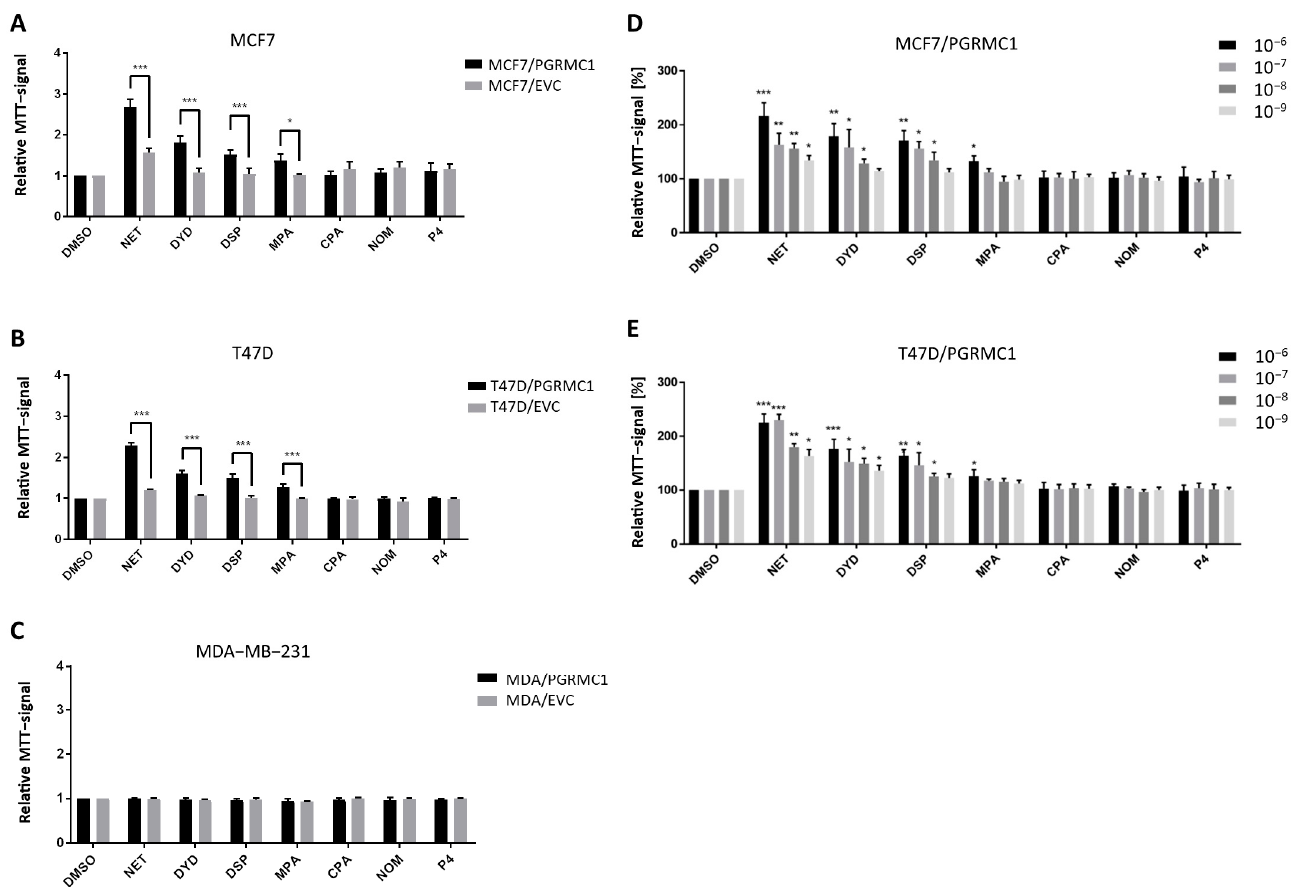
Figure 1. PGRMC1 promotes proliferation of breast cancer cells upon progestin treatment. Relative MTT-signal as surrogate for cell number of ( A ) MCF7/PGRMC1 and MCF7/EVC cells, ( B ) T47D/PGRMC1 and T47D/EVC cells, ( C ) MDA-MB- 231/PGRMC1 and MDA-MB-231/EVC cells. Cells were treated with different progestins in the concentration of 10 − 6 M. Relative MTT-signal of ( D ) MCF7/PGRMC1 and ( E ) T47D/PGRMC1 cells treated with different concentrations of progestins (10 − 6 –10 − 9 M) for 72 h. Values were normalized to respective DMSO treated cells. Statistical analysis was performed with twoway ANOVA and Bonferroni post − hoc test. *: p < 0.05, **: p < 0.01, ***: p < 0.001.